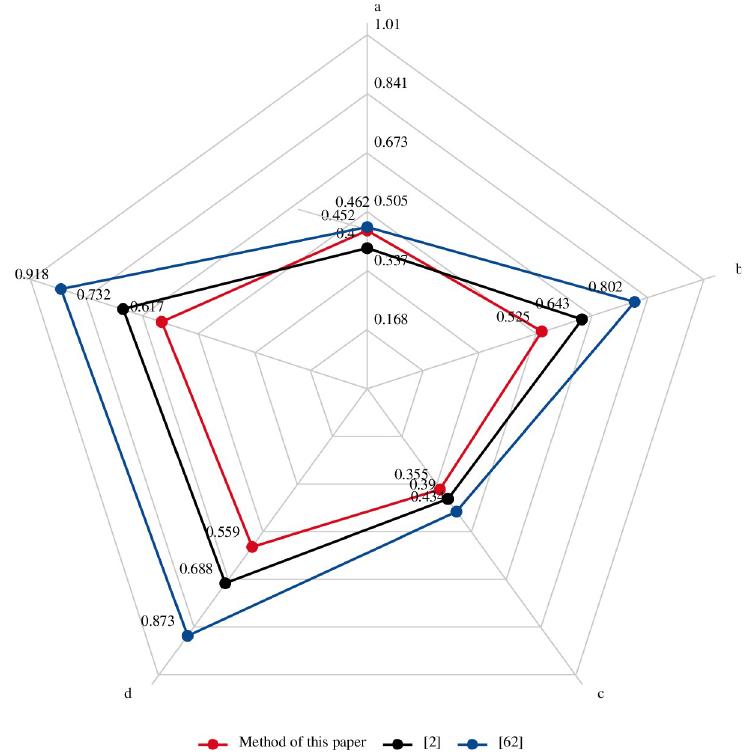
Fig 6. Radar chart for the three